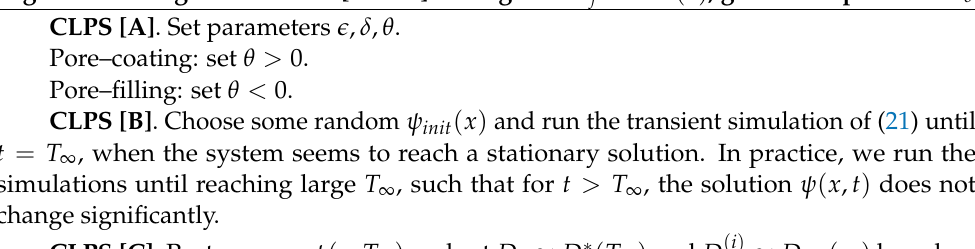
Algorithm 2. Algorithm CLPS [A-B-C]: for a given D f and V ( 0 ) , generate a possible D o